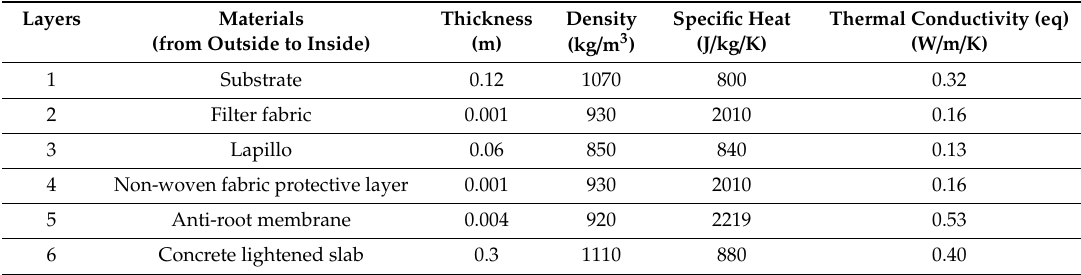
Table 5. Stratigraphy of the extensive green roof (thickness: 0.49